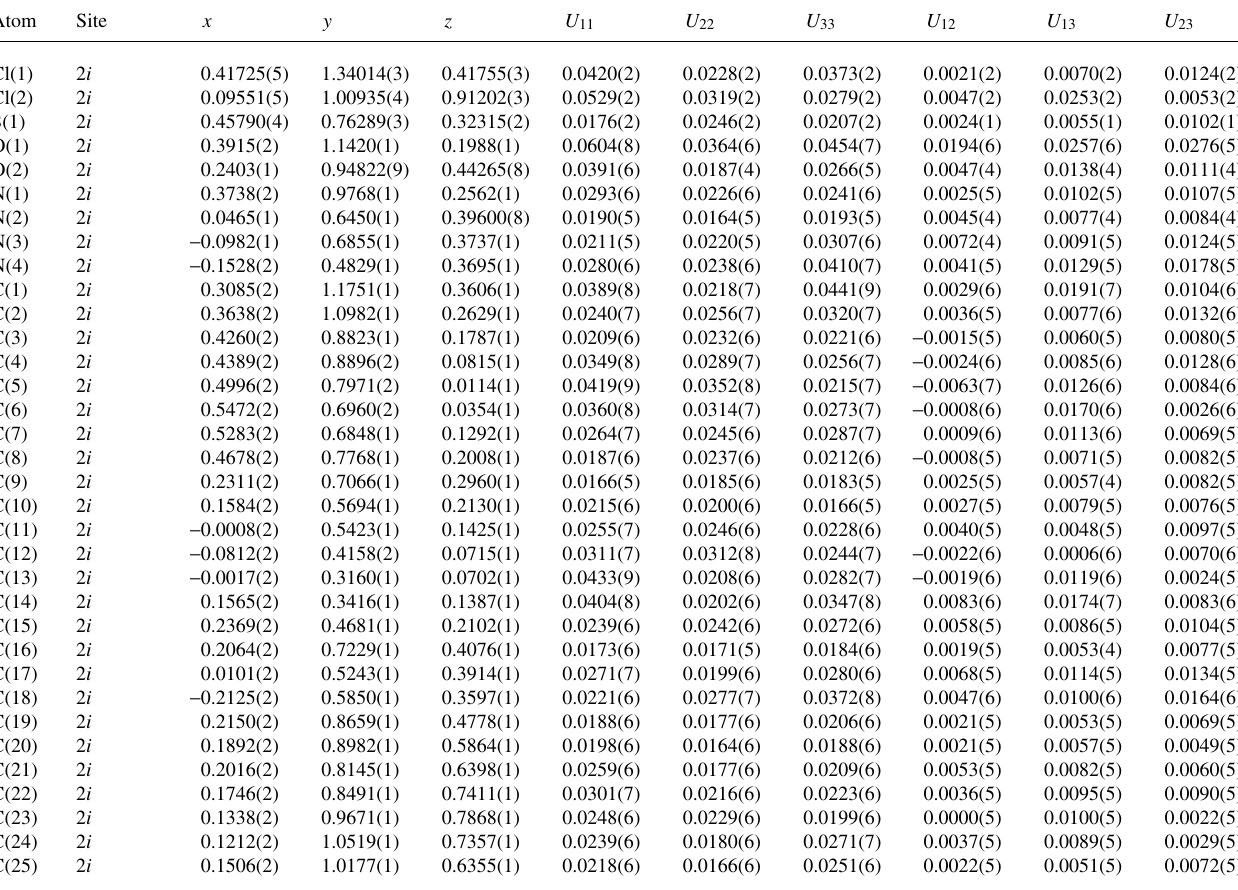
Table 3. Atomic coordinates and displacement parameters (in Å 2 )